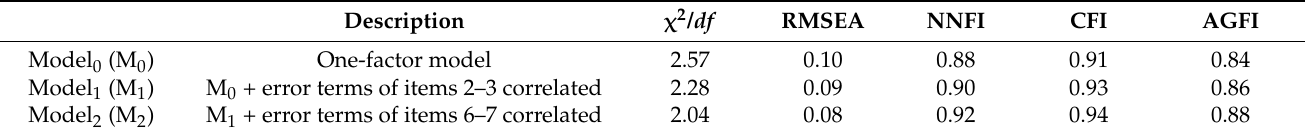
Table 2. Fit Values of the E-SuPer Scale for Sample B ( n =